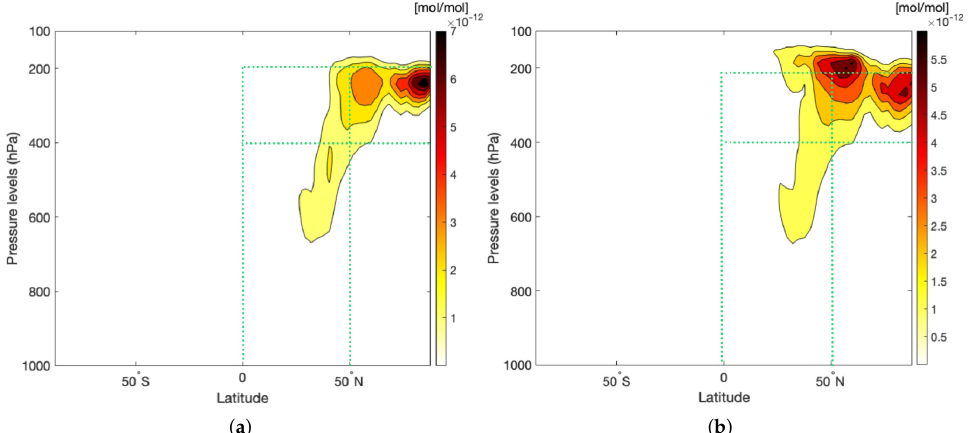
Figure 17. Zonal mean mixing ratio of NO y atf (mol/mol) for climate-optimised ( a ) lateral re-routing and ( b ) vertical re-routing on 8 August 2016, a week after the release of the emissions. The green dotted boxes indicate four regions of interest, where further analysis is carried